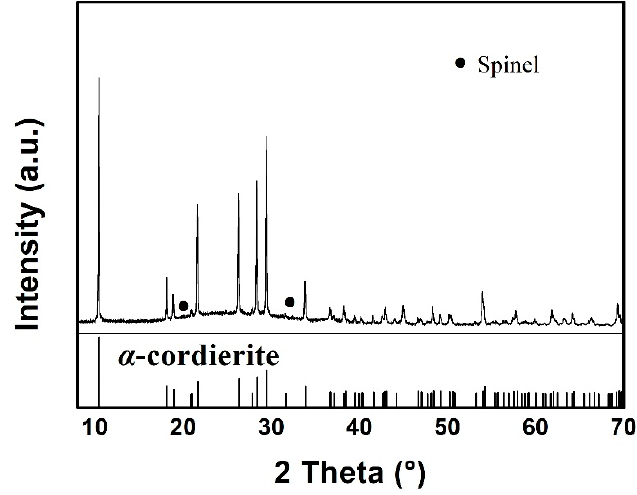
Figure 1. X-ray diffraction patterns of MAS .